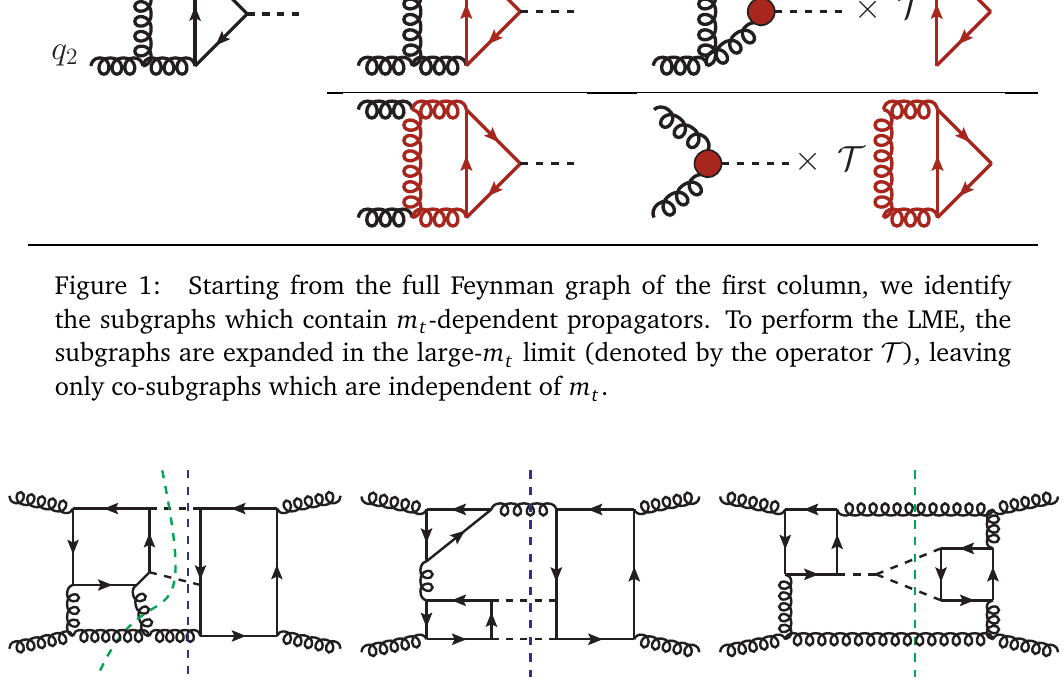
Figure 2: Forward-scattering diagrams which contribute to the real-real and real- virtual corrections to NNLO double–Higgs boson production. The blue and green dashed lines denote three- and four-particle cuts through the final state